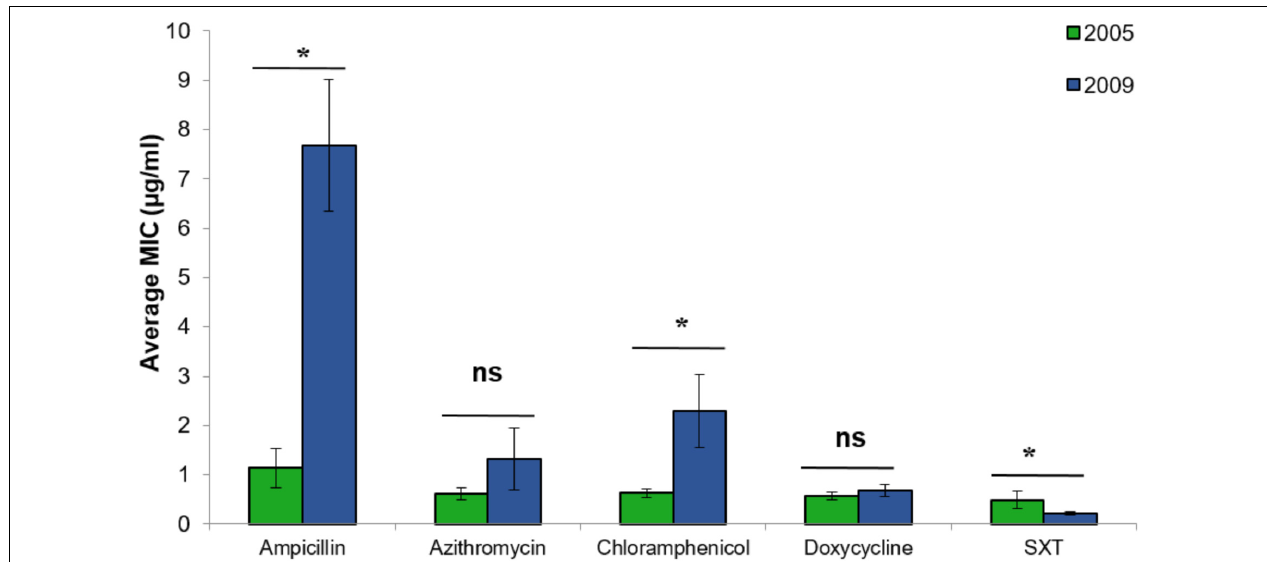
FIGURE 3 | Comparative analysis of the MIC (average ± std. error) for each of the studied antimicrobial agents toward V. cholerae strains that were isolated from chironomids in 2005 (green bars, n = 18), and 2009 (blue bars, n = 32). Asterisks represent significant differences in MICs by Student’s t -test ( p < 0.05). ns, no significant difference; SXT, Trimethoprim (TMP) and sulfamethoxazole.